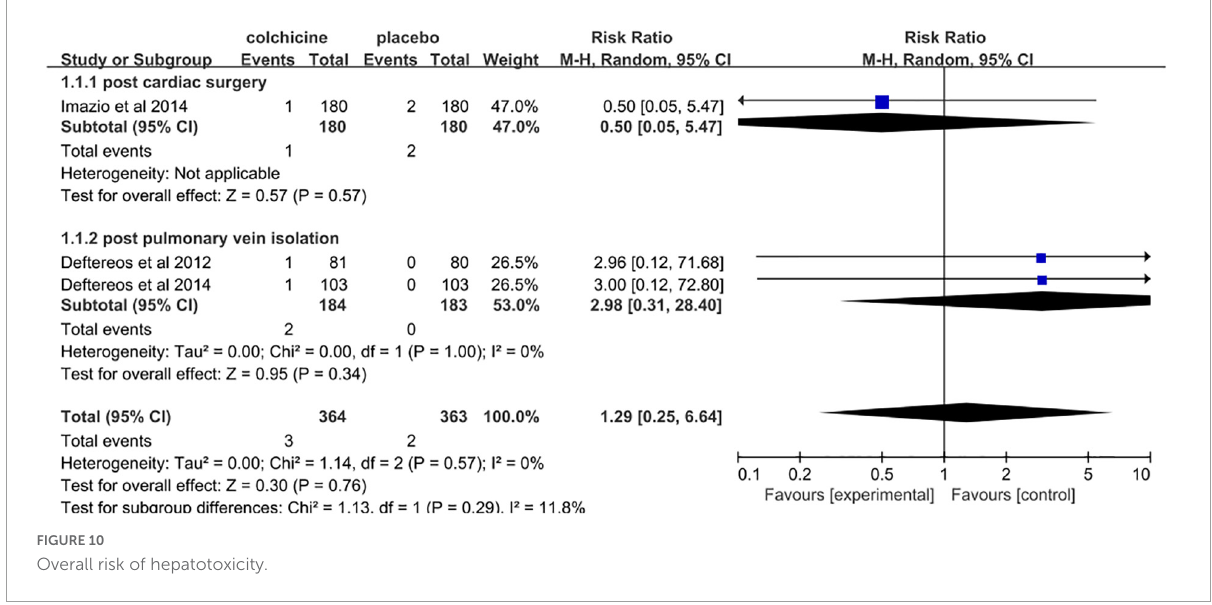
FIGURE10 Overall risk of hepatotoxicity.